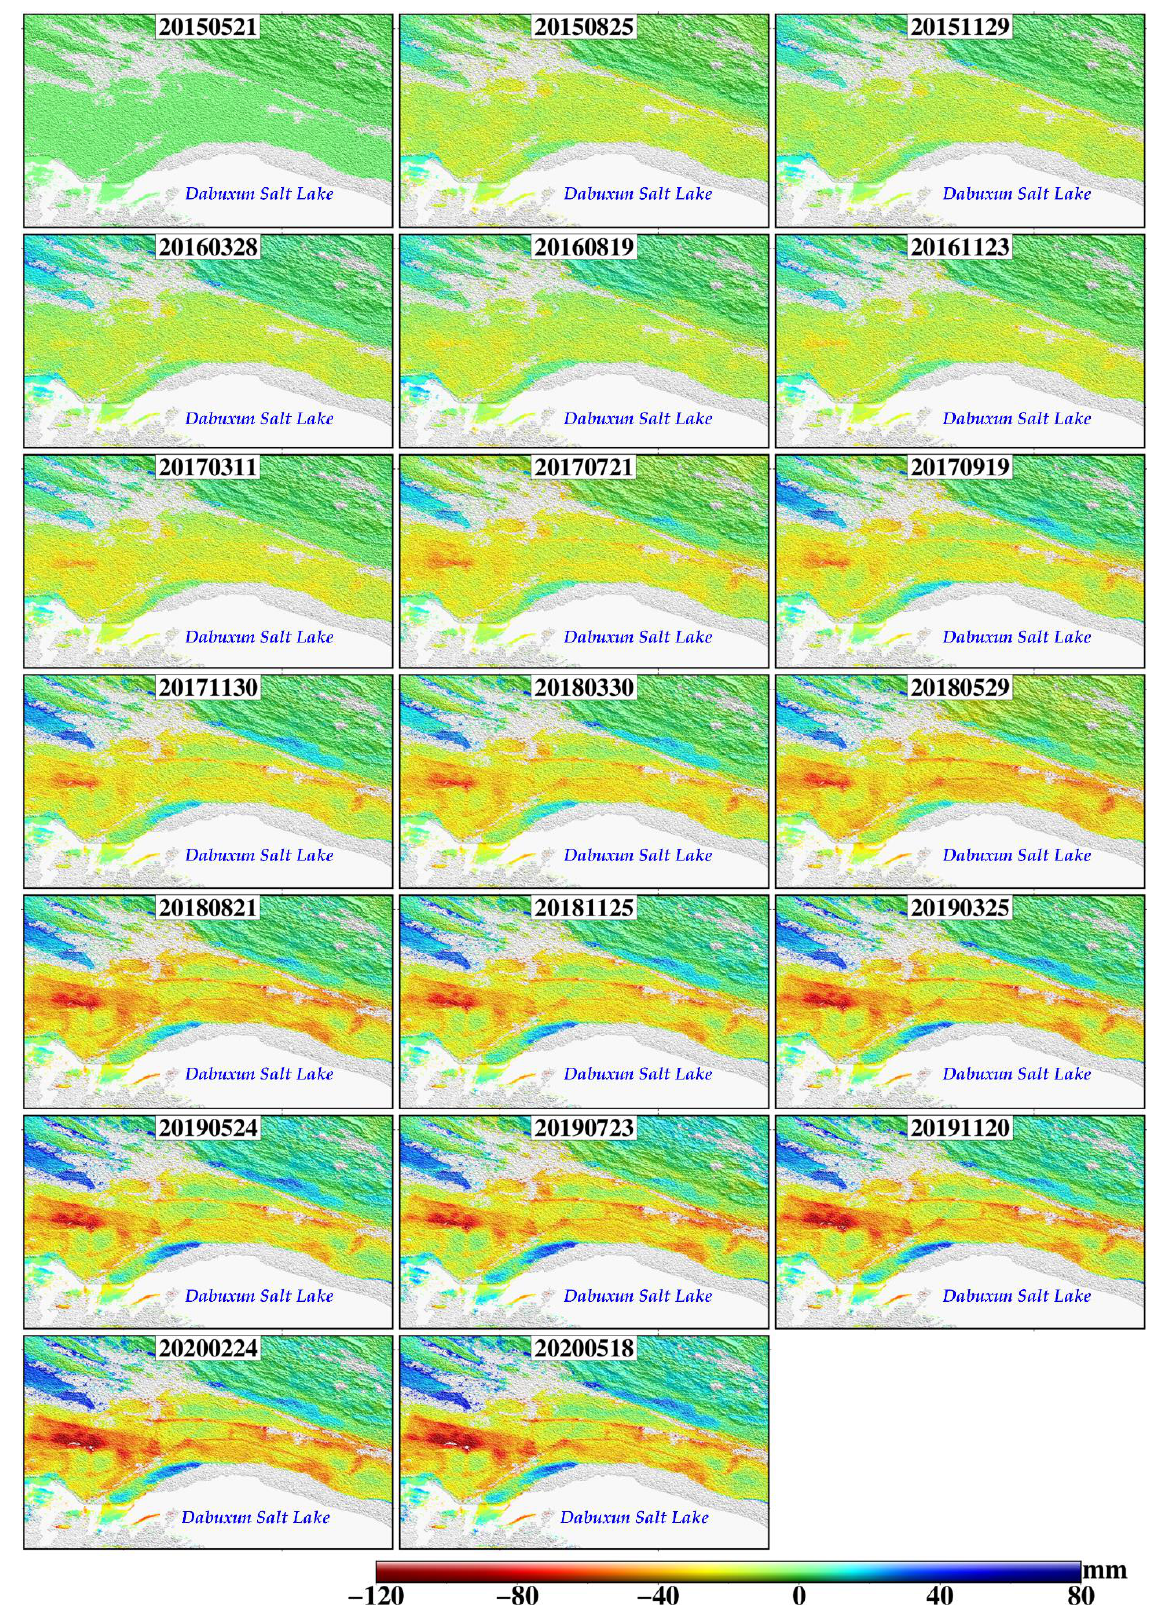
Figure 11. The accumulated deformation maps of area (a) from May, 2015 to May, 2020, each subplot is depicted with about 3 months’ increments from the deformation results of TS-InSAR.